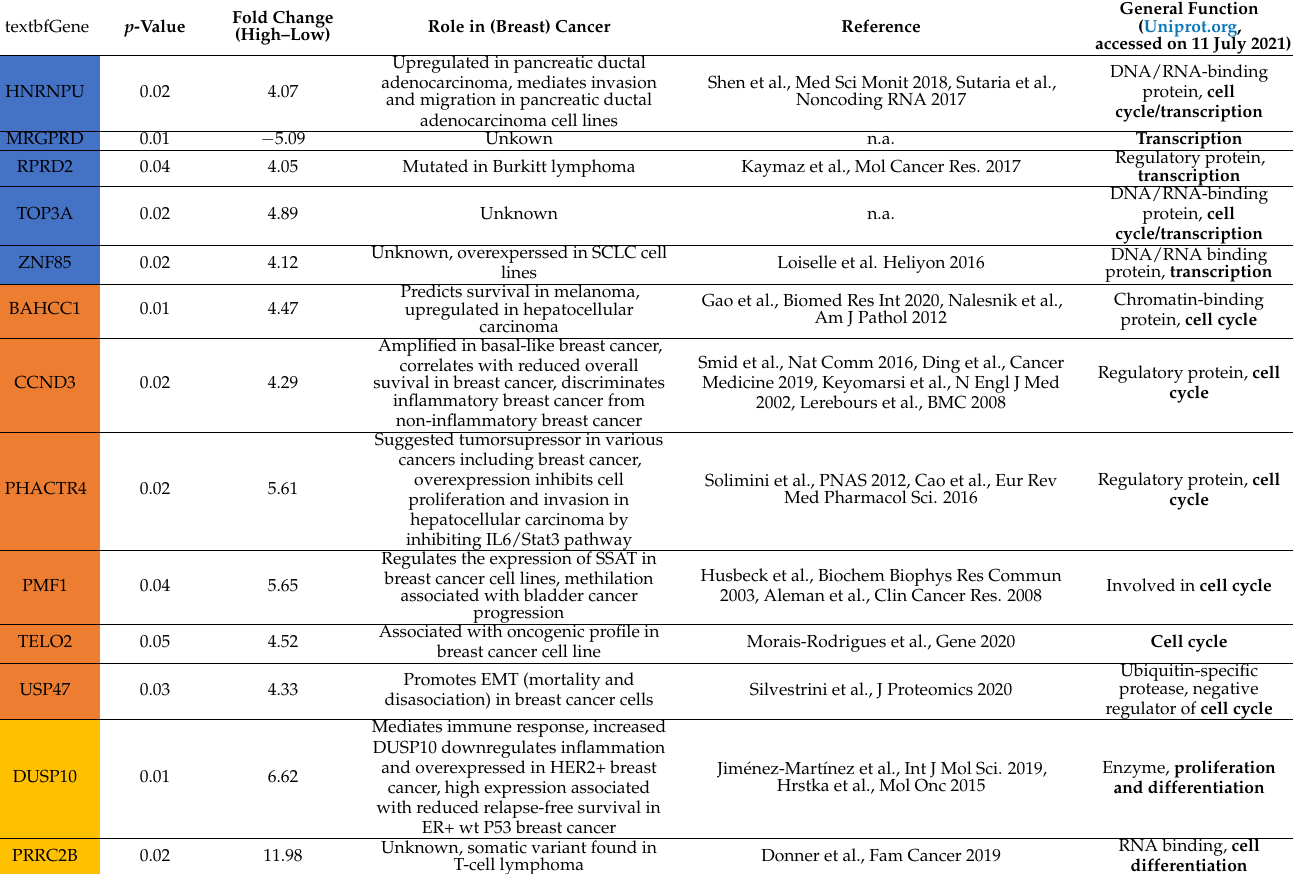
Table 2. Differentially expressed genes